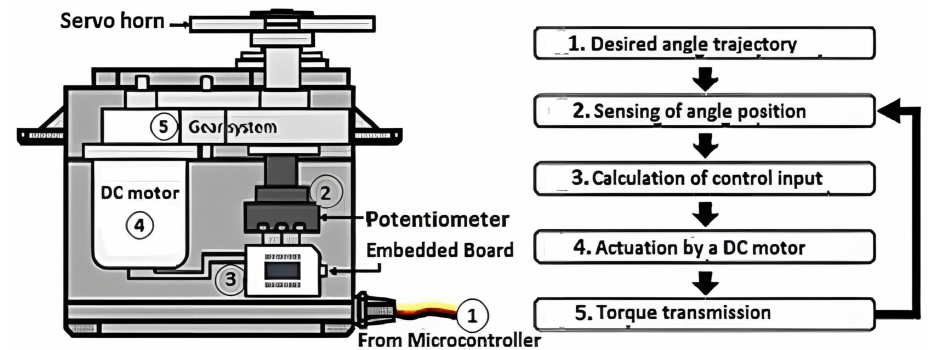
Figure 4. Schematic of an RC servo motor